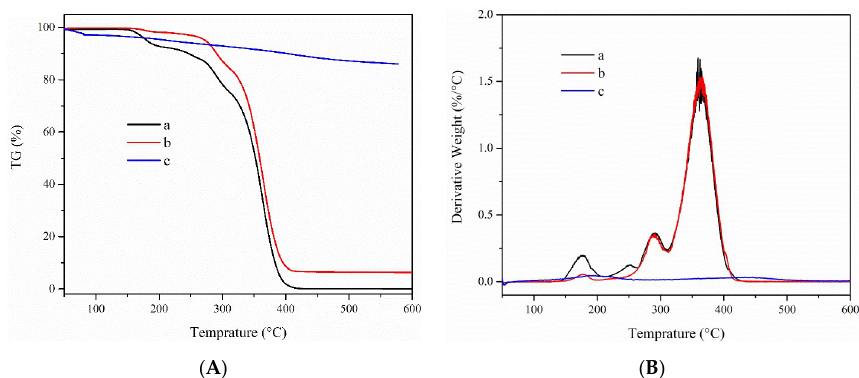
Figure 3. Thermo-gravimetry (TG) curves ( A ) and DTG curves ( B ) of PMMA, poly(OPal-MMA), and OPal. (a) PMMA; (b) poly(OPal-MMA); (c) OPal.